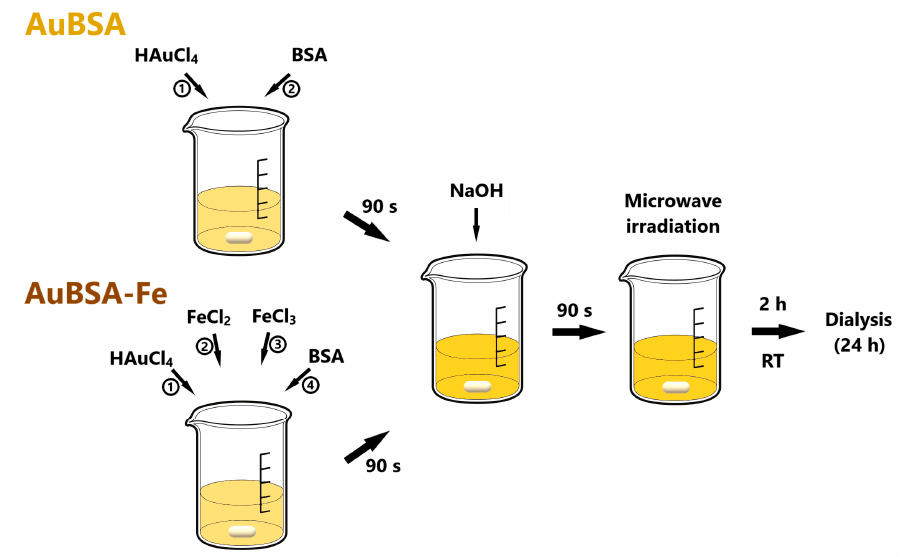
Figure 1. Schematic depiction of AuBSA and AuBSA-Fe nanocomposites.